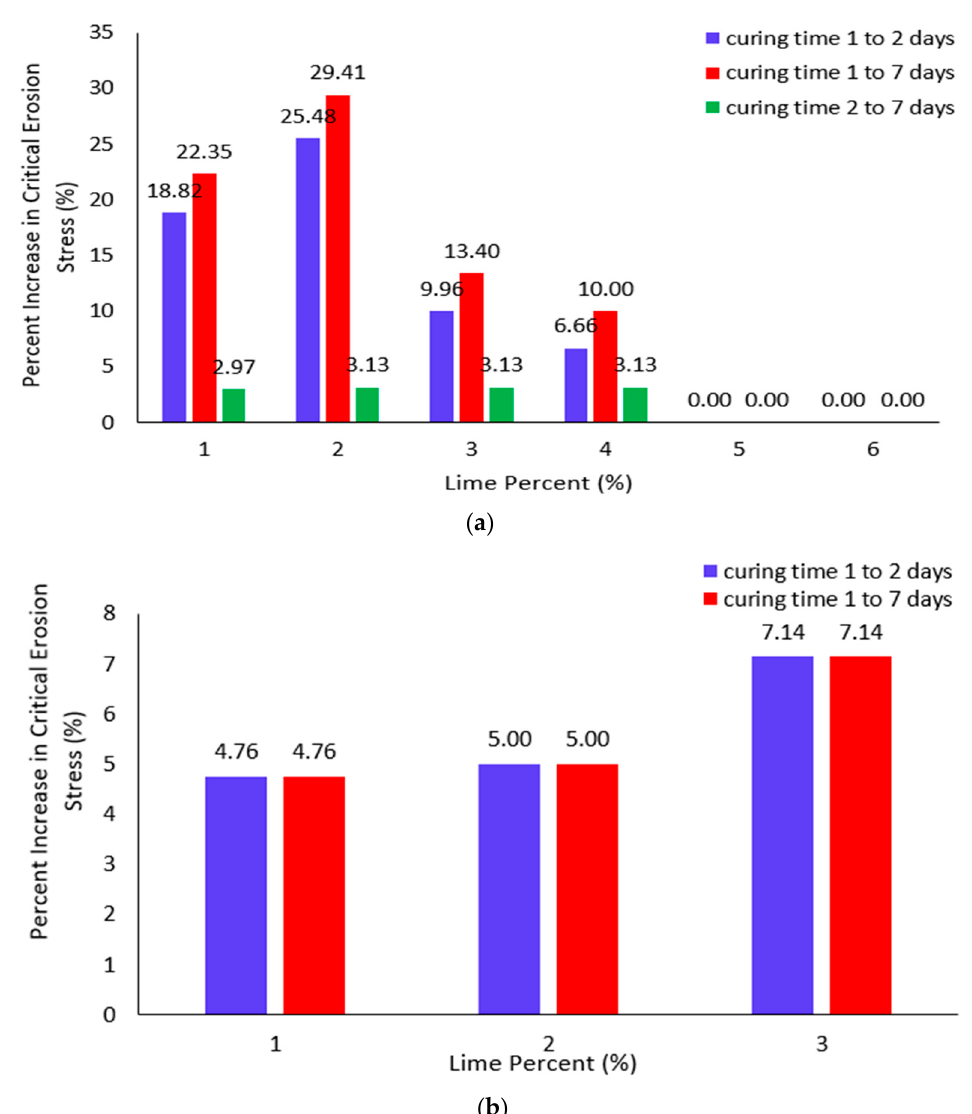
Figure 5. Percent increase in critical erosion stress (%) due to the increase in curing times for di ff er- ent lime percentages in ( a ) Soil #1 and ( b ) Soil